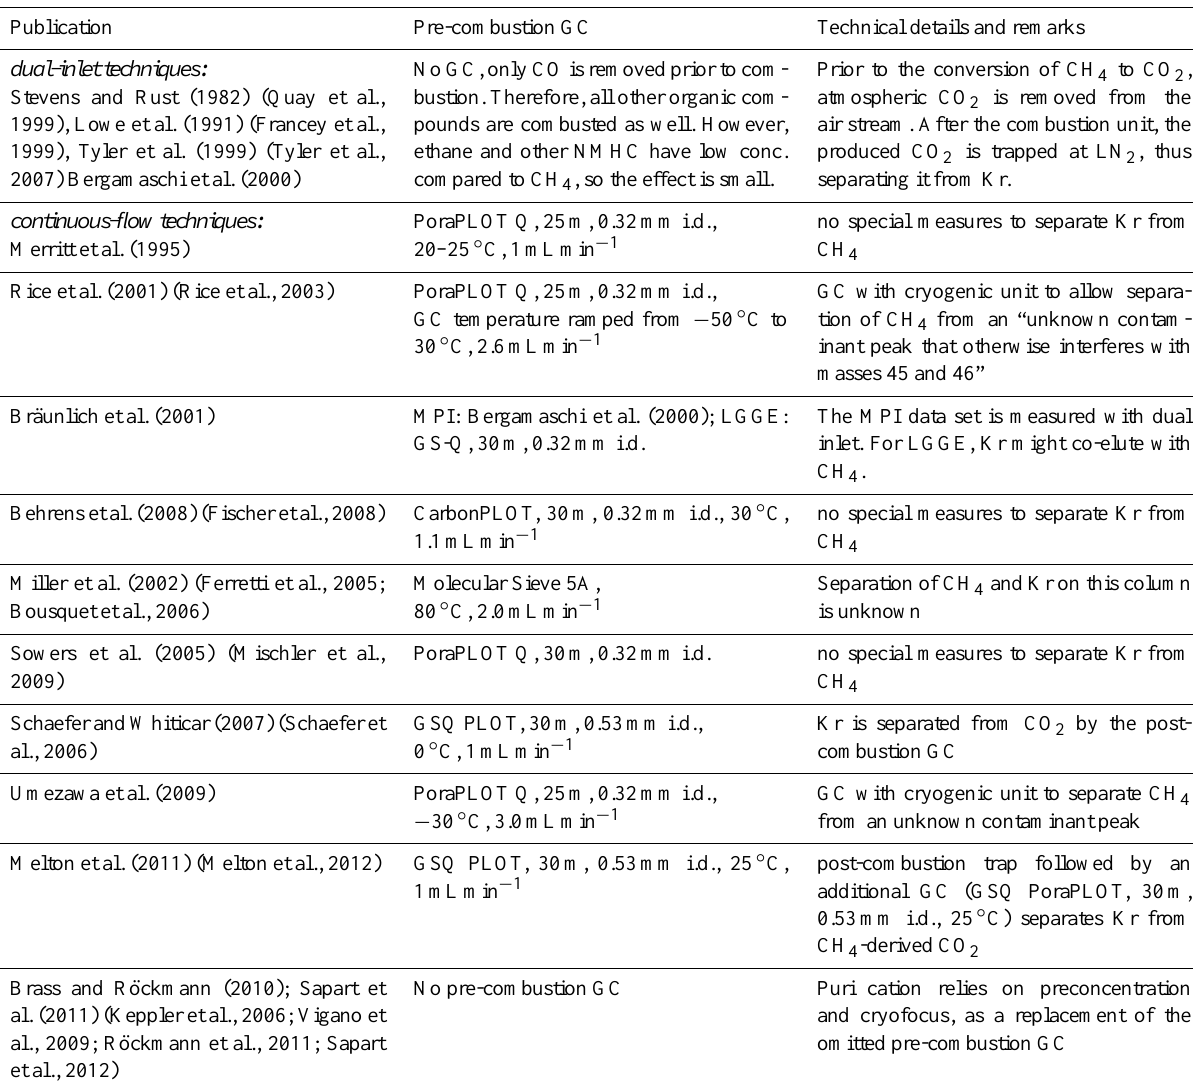
Table 1. Collection of publications dealing with δ 13 C-CH 4 measurements in view of possible Kr interferences. The collection is not exhaus- tive and lists only some of the publications in the field of ice core and atmospheric measurements. To allow a faster orientation of which data set is produced by which method, we used the following scheme: technical paper (data